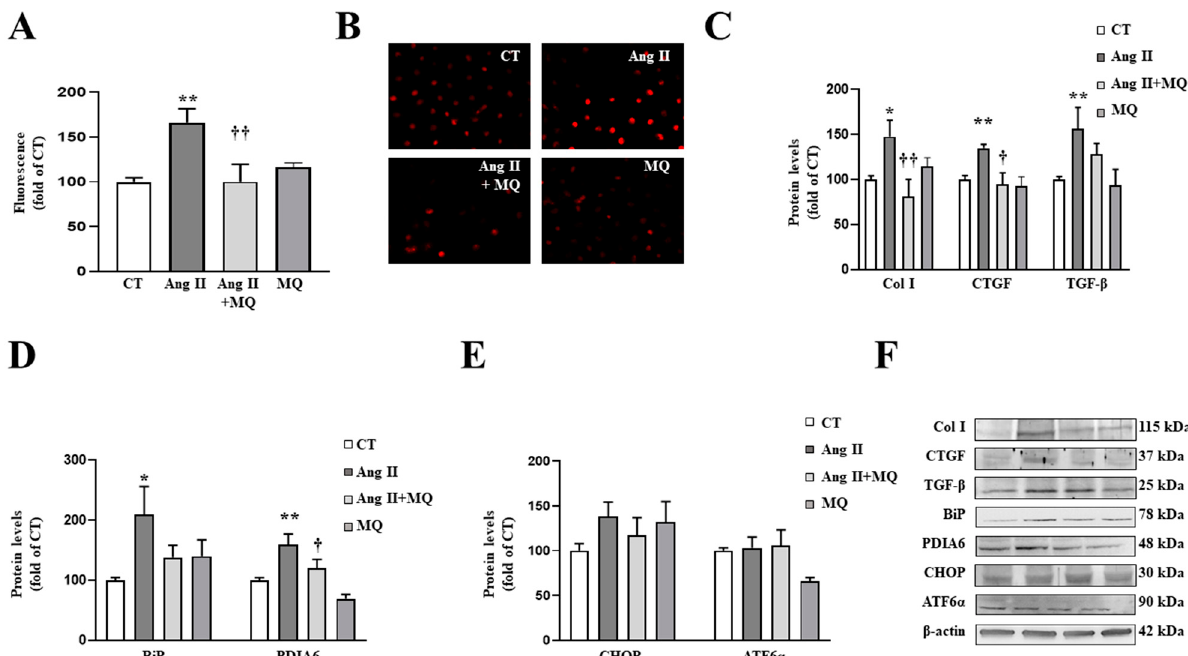
Figure 4. Mitochondrial oxidative stress mediates the prooxidant, profibrotic and the endoplasmic reticulum stress activation induced by angiotensin II (Ang II) in vascular smooth muscle cells (VSMCs). ( A , B ) Effects of the mitochondrial antioxidant MitoQ (MQ; 5 nM) on superoxide anion production. Quantification of cells labelled with the oxidative dye dihydroethidium ( A ) and representative microphotographs (magnification 40×) ( B ). Protein levels of ( C ) collagen type I (Col I), connective tissue growth factor (CTGF) and transforming growth factor-beta (TGF- β ); ( D ) immunoglobulin binding protein (BiP) and protein disulfide isomerase family A member 6 (PDIA6); ( E ) CCAAT-enhancer-binding protein homologous protein (CHOP) and activating transcription factor 6-alpha (ATF6 α ) in VSMCs treated with Ang II (10 − 6 M) for 24 h in the presence or in the absence of MQ. ( F ) Representative blots for protein expressions. Bars graphs represent the mean ± SEM of four to six assays normalized for β -actin. * p < 0.05, ** p < 0.01, vs. control cells. † p < 0.05, †† p < 0.01, vs. Ang II-treated VSMCs.